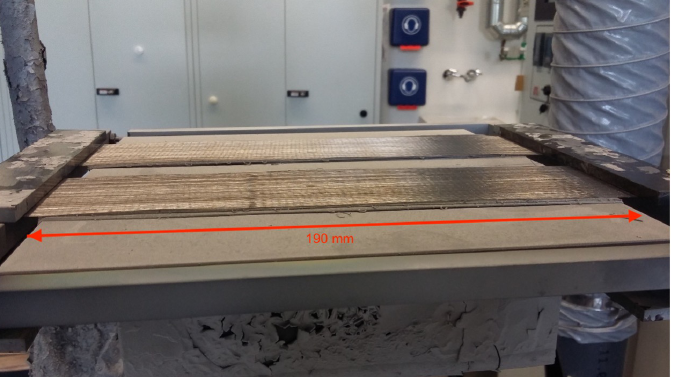
Figure 4. Heating table incl. tungsten substrate plate and Frame with weave.